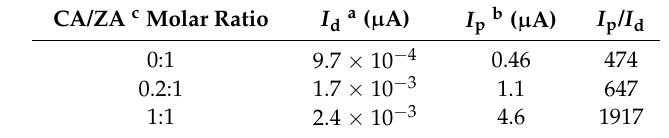
Table 1. Summary of the ultraviolet (UV) detecting performance of inverse opal (IO) film photodetectors. CA/ZA c Molar Ratio I d a ( µ A)